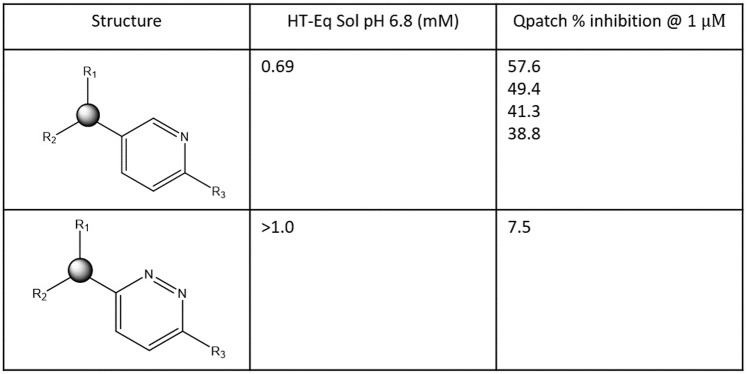
Representative activity cliffs for a proprietary hERG blocker series differing solely in the 6-ring substructures (residing within the putative BC feature set).The large decrease in percent inhibition @ 1 μM for structure 2 compared with structure 1 is attributable to increased polarity and solubility/de-solvation cost of the pyridazyl versus the pyridyl group (consistent with the lack of hERG-contributed H-bond replacements for the water solvating this moiety in the unbound state).